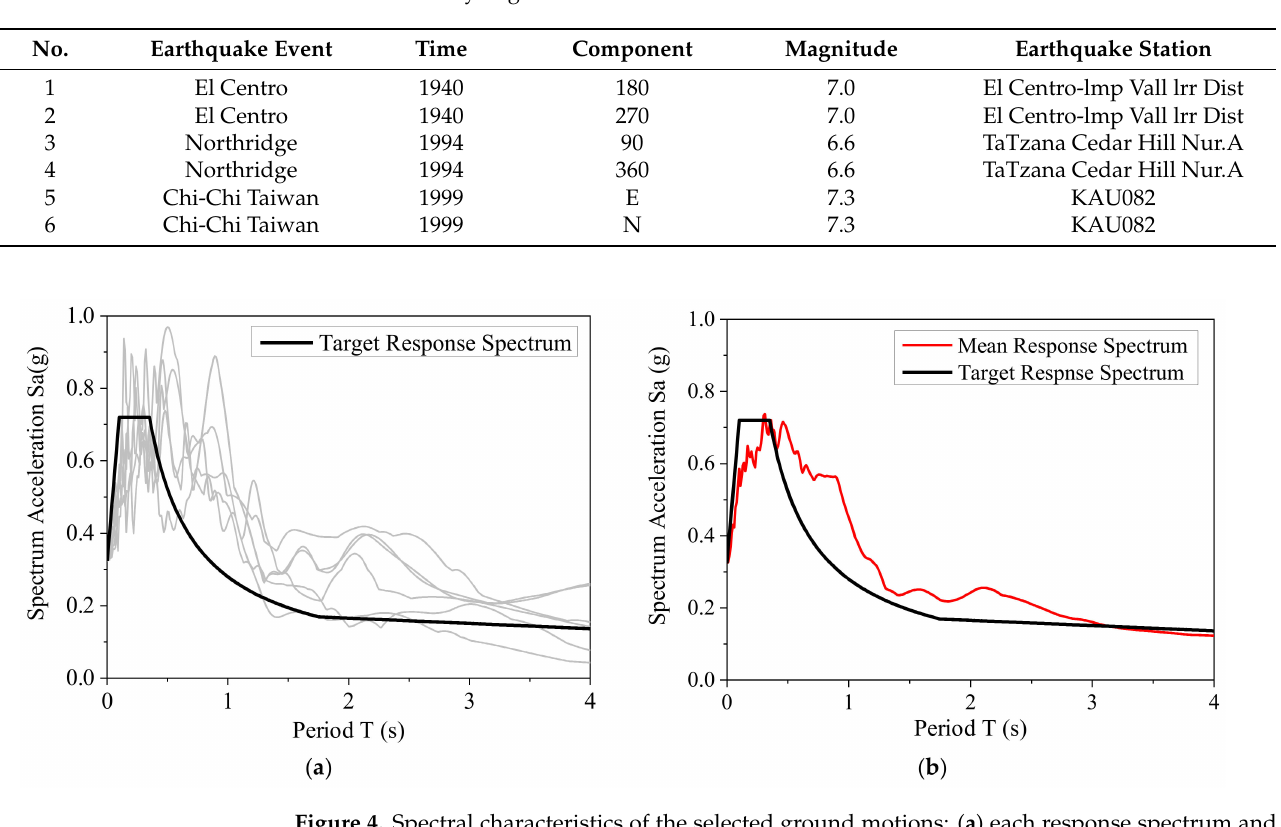
Table 7. Summary of ground motion records.